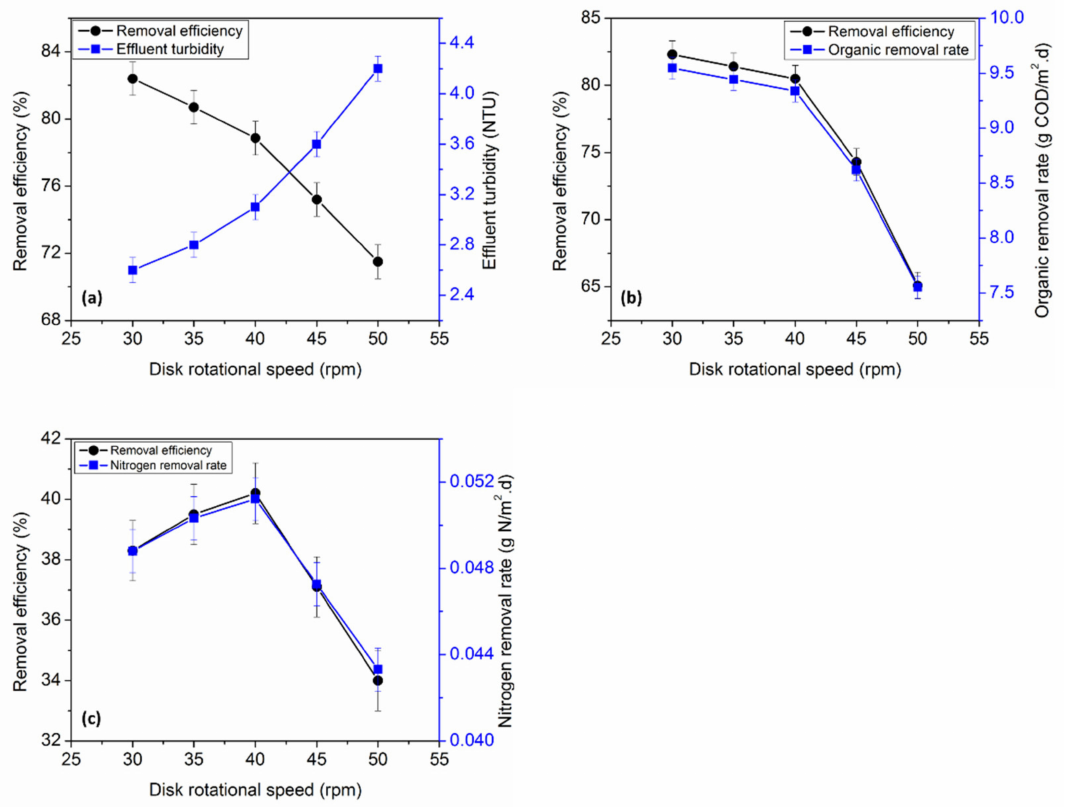
Figure 4. Effect of disk rotational speed on ( a ) turbidity, ( b ) COD, and ( c ) TN